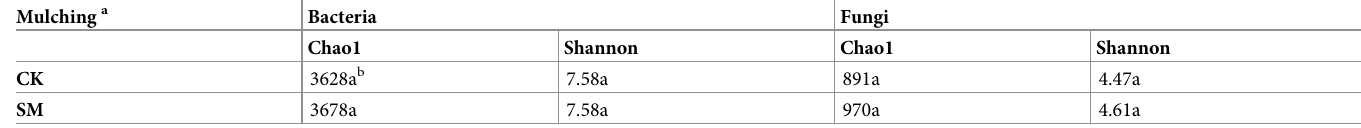
Table 4. Soil bacterial and fungal diversity (Shannon index) and richness (Chao1 index) under different mulching methods before incubation. Mulching a